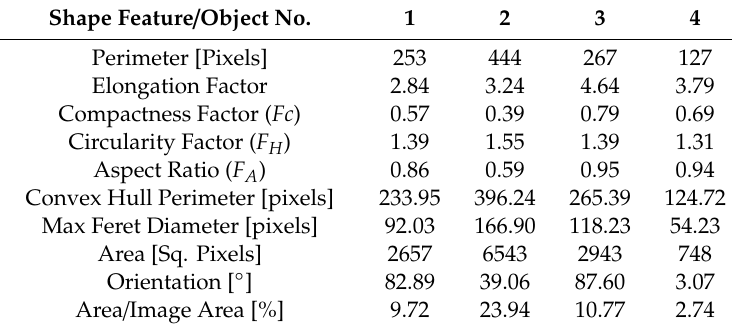
Table 1. Selected shape features for Figure